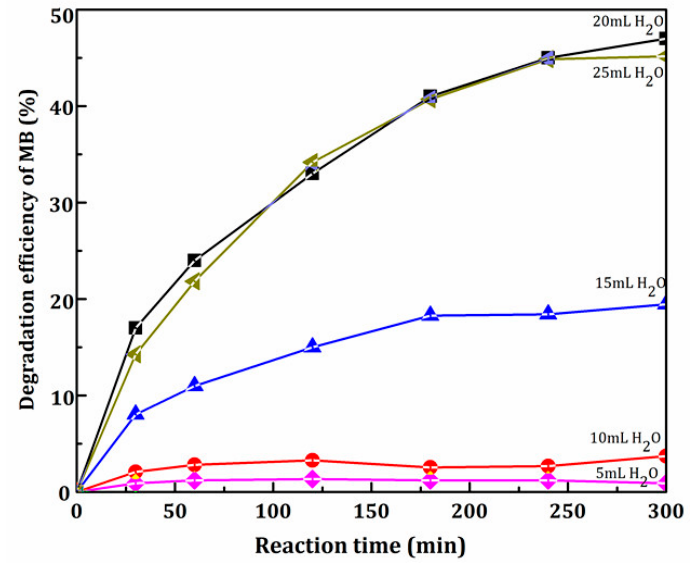
Figure 2. Effect of different dosage of water on MB degradation.